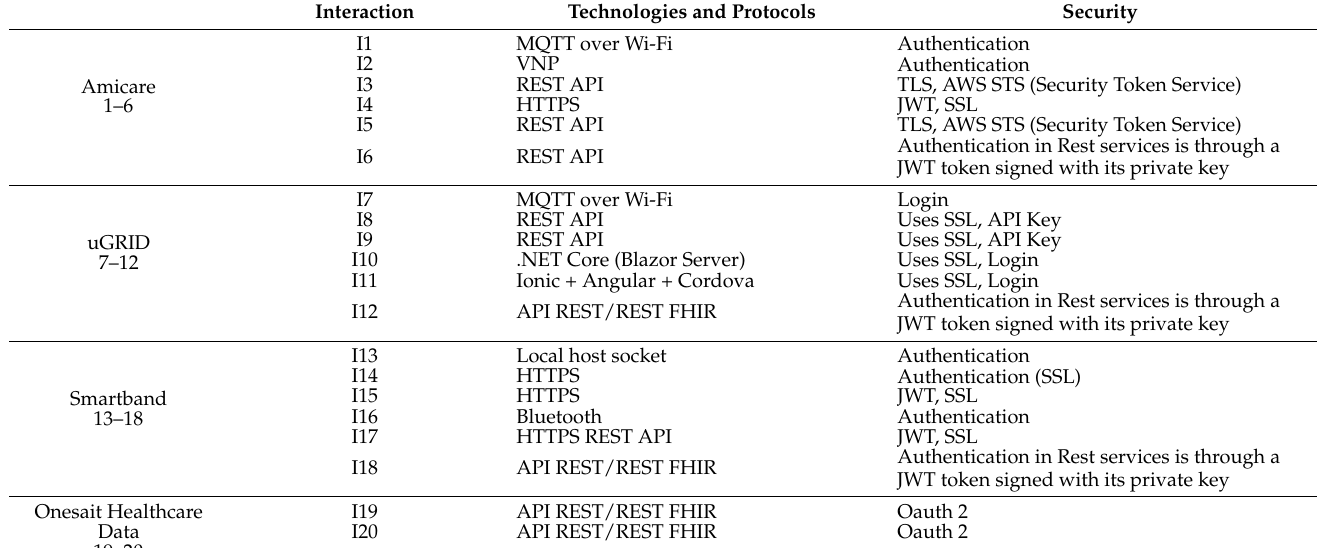
Table 2. Interactions between the elements of the Murcia pilot architecture and their technologies, protocols, and